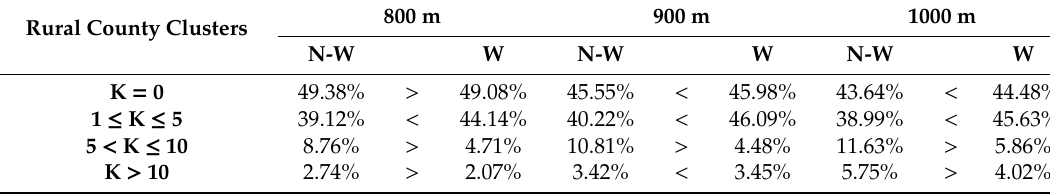
Table 2. KNN for rural county